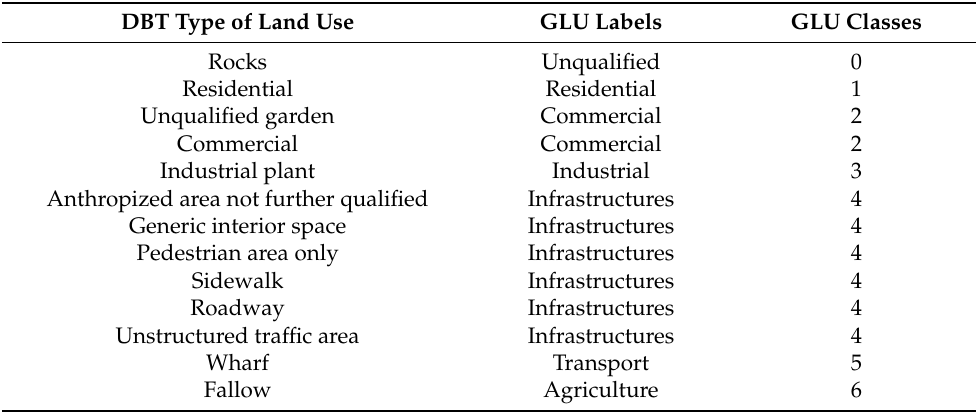
Table 5. General Land Use class assignment.